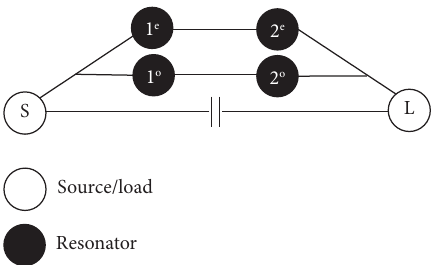
Figure 3: Coupling scheme of the proposed